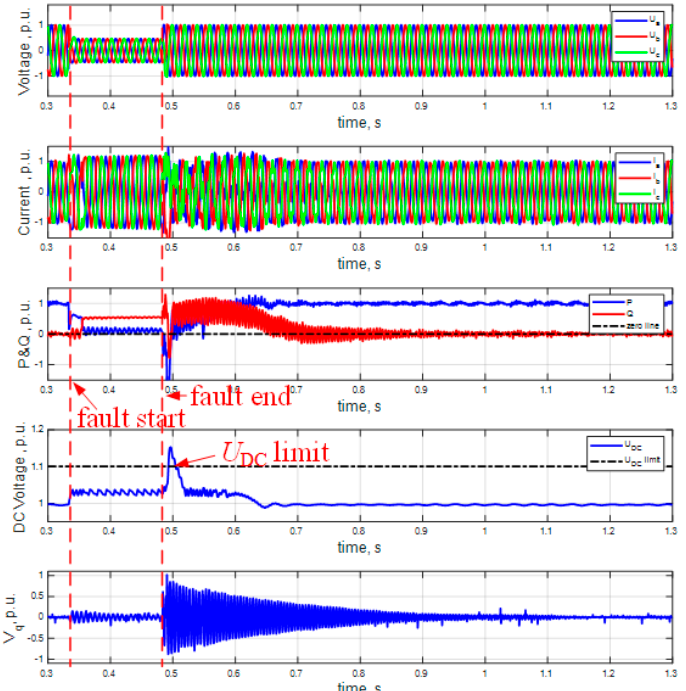
Figure 13. With reactive current injection, a reduction rate of I ∗ q = 5 p.u./s, the active power reversed for a long time due to the slower reactive current exit rate (P curve below the black dashed line), eventually causing the DC voltage to exceed the upper limit (black dashed line).